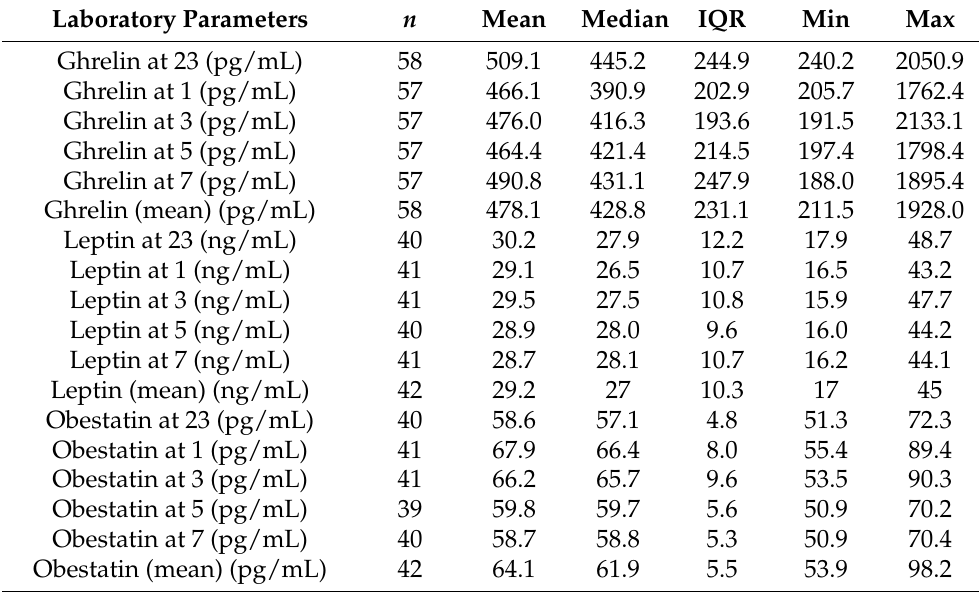
Table 2. Distribution of ghrelin, leptin and, obestatin in the study group.